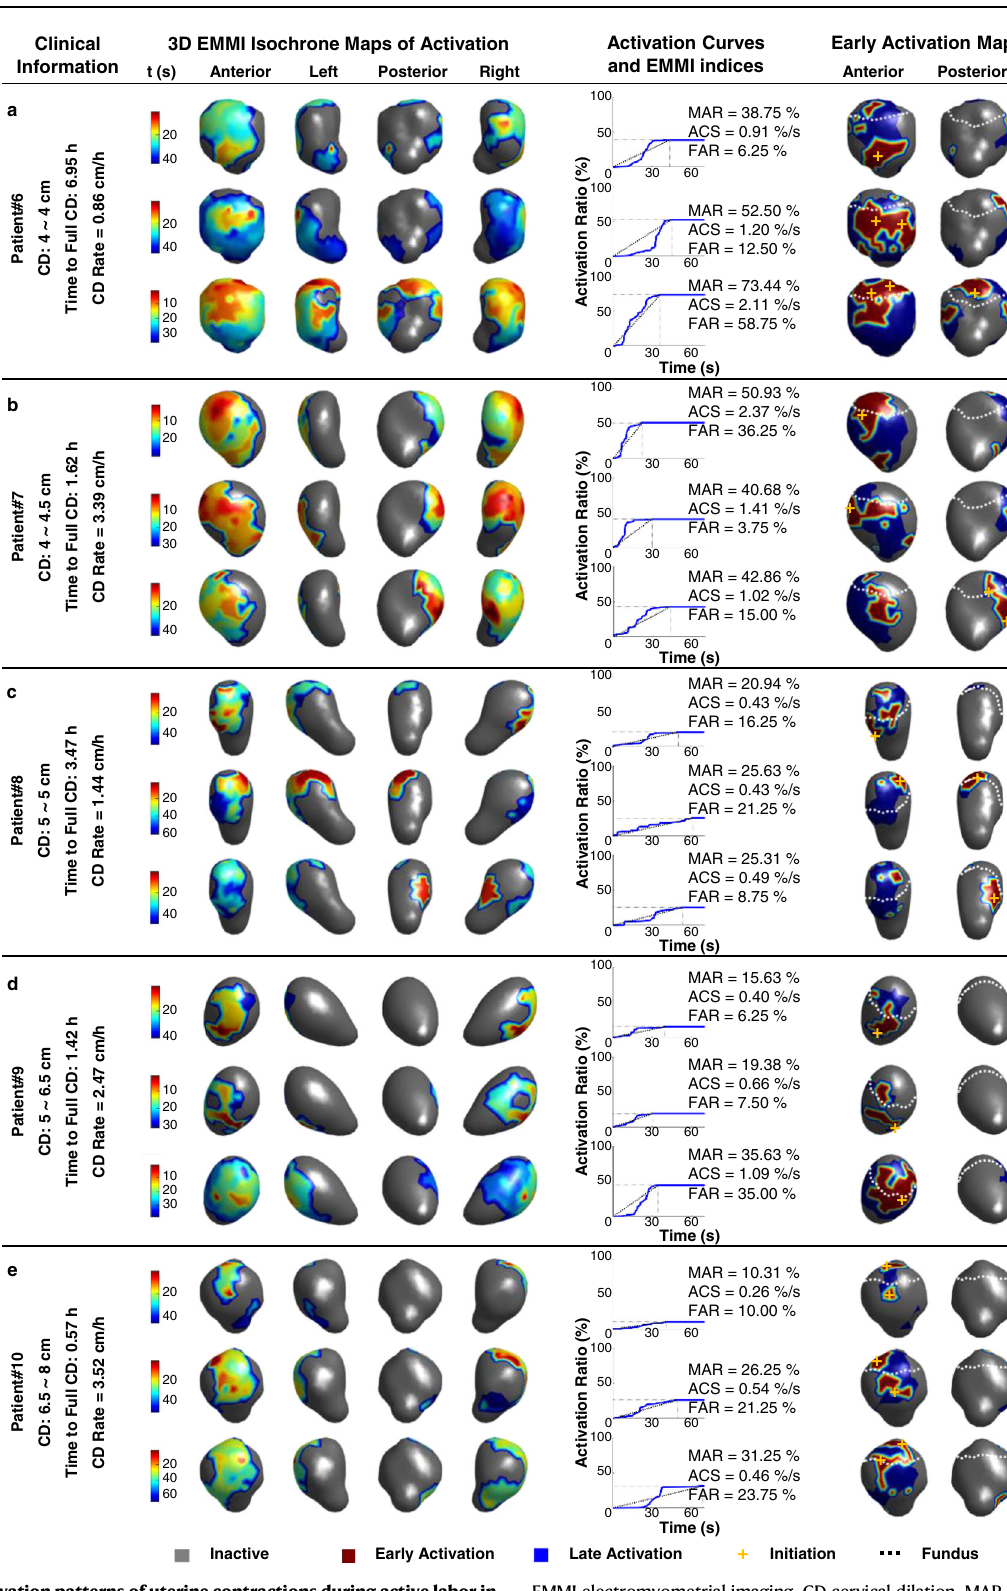
EMMI electromyometrial imaging, CD cervical dilation, MAR maximal activation ratio,ACSactivationcurveslope,FARfundalearlyactivationratio.Sourcedataare provided as a Source Data fi